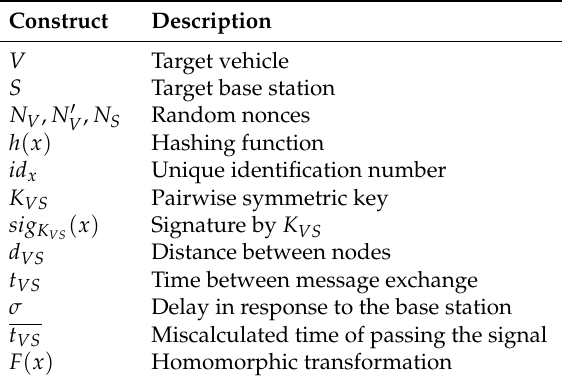
Table 1. Key constructs utilized in this